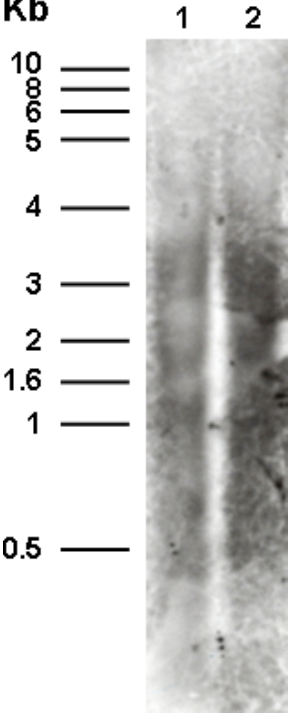
Figure 3. Southern hybridization analysis of Ancylostoma caninum genomic DNA to a probe specific for the bandit transposon. The genomic DNAs were cleaved with endonucleases Xba I (lane 1) and Xho I (lane 2). Molecular size standards in kilobase pairs (kb) are shown at the left.